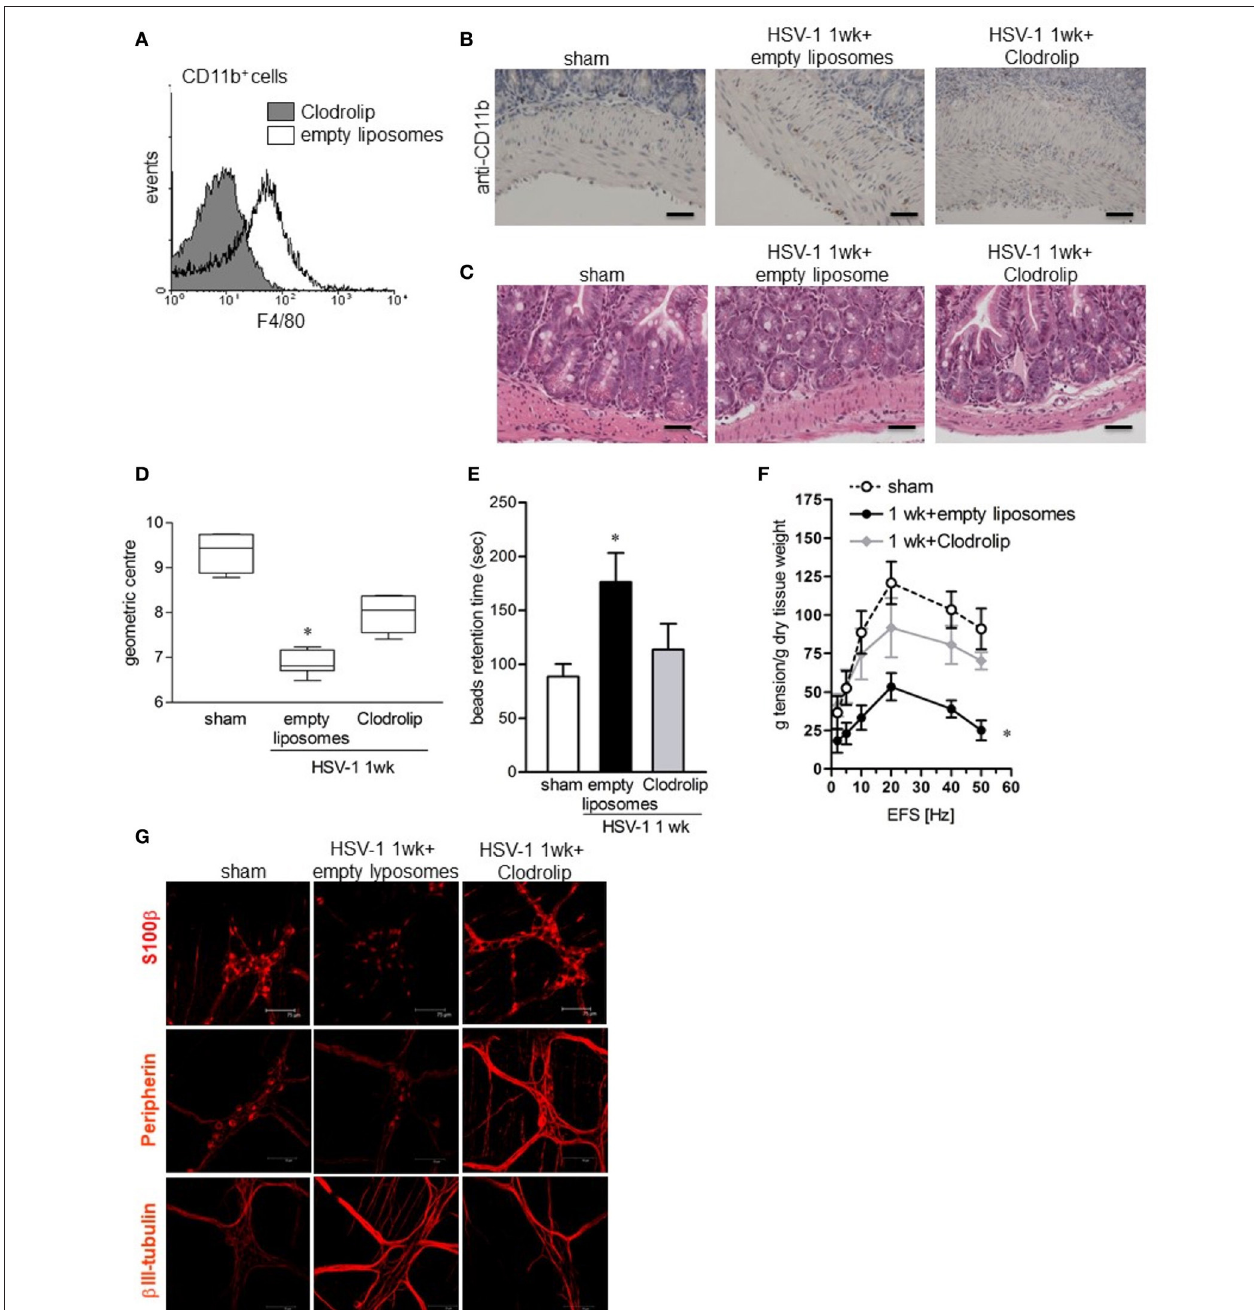
FIGURE 7 | Depletion of macrophage in the LMMP ameliorates HSV-1-induced alterations of the ENS. (A) Cells were isolated form LMMP of 1-week HSV-1 infected mice treated with Clodrolip or empty liposomes as control. To confirm macrophages depletion, F4/80 expression was evaluated by flow cytometry in CD11b + cells. (B) Sections of ileum obtained from 1-week HSV-1 infected mice treated with Clodrolip or empty liposomes were subjected to immunohistochemistry for CD11b. Scale bars: 40 µ m. (C) Histological analysis of samples of ileum obtained from 1-week HSV-1 infected mice treated with empty liposomes or Clodrolip. Sections were subjected to H&E staining. Scale bars: 40 µ m. Images are representative of three separate experiments. (D) At 1-week post-IG HSV-1 inoculum, mice injected with Clodrolip or empty liposomes were administered with non-absorbable FITC-labeled dextran and sacrificed 60min later. Intestinal transit was reported as the geometric center of distribution of the fluorescent probe throughout the ileum. (E) Time (seconds, sec) required for expulsion of a glass bead inserted into the rectum in Clodrolip or empty liposomes treated mice at 1 week of IG infection. (F) EFS-elicited contractions in segments of ileum obtained from mice at 1 week of IG infection and treated with Clodrolip or empty liposomes. Data are reported as mean ± SEM. n = 6 mice per group. *Denotes P < 0.01 compared to sham infected mice. (G) Immunohistochemistry for S-100 β , peripherin, and β III-tubulin on whole mount preparations of distal ileum obtained from 1-week HSV-1 infected mice and treated with Clodrolip or empty liposomes. Representative images of three separate experiments. Scale bars: 75 µ m.